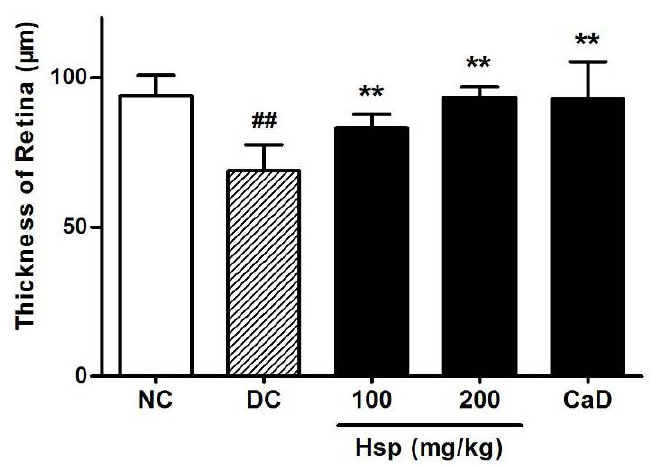
Figure 6. The effects of Hsp and CaD on the thickness of retinas. ## p < 0.05 as compared with the NC group; * p < 0.05, ** p < 0.01 as compared with the DC group; NC, Normal Control; DC, Diabetic Control. The data represent means ±